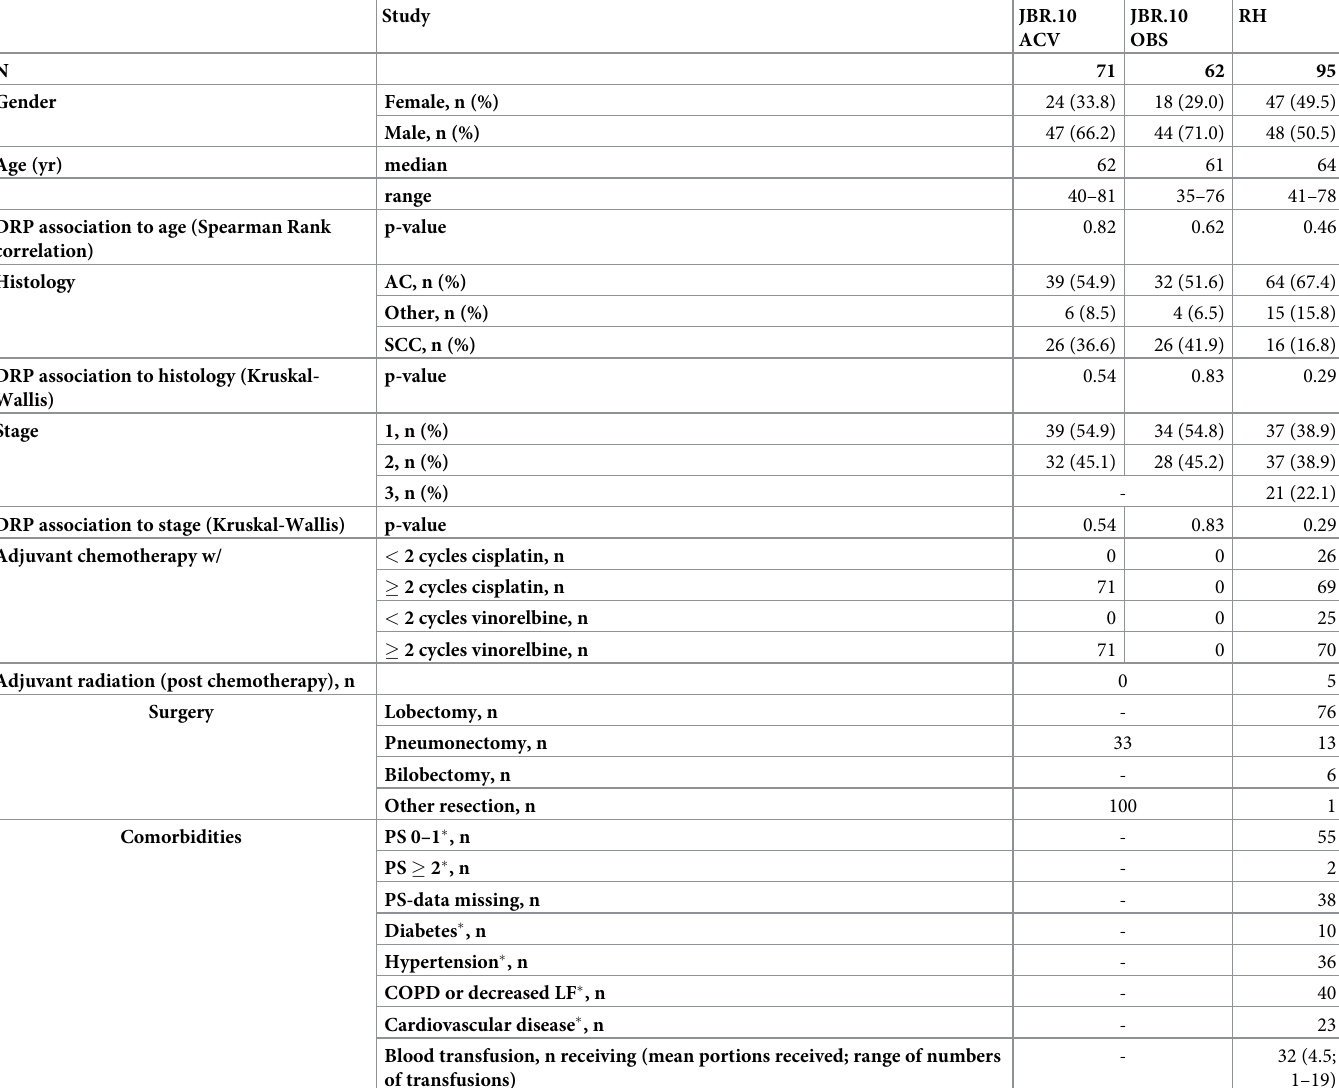
Table 1. Baseline demographics and association in the treated